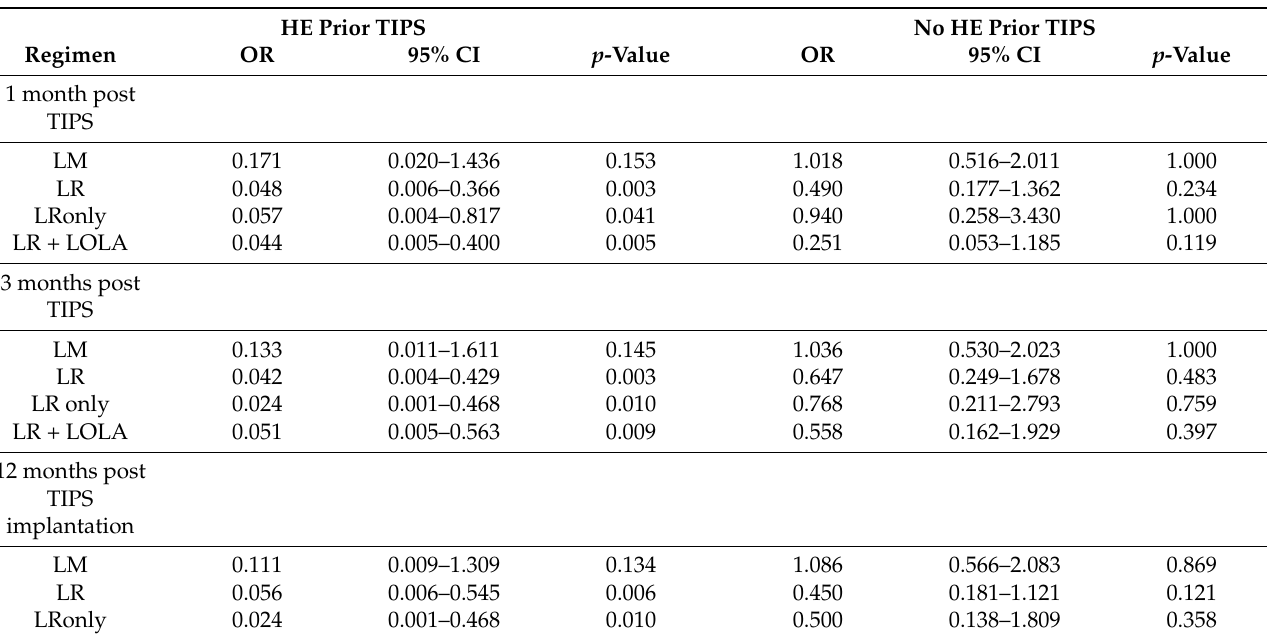
Table 3. Logistic regression analysis for HE post TIPS implantation by prophylactic